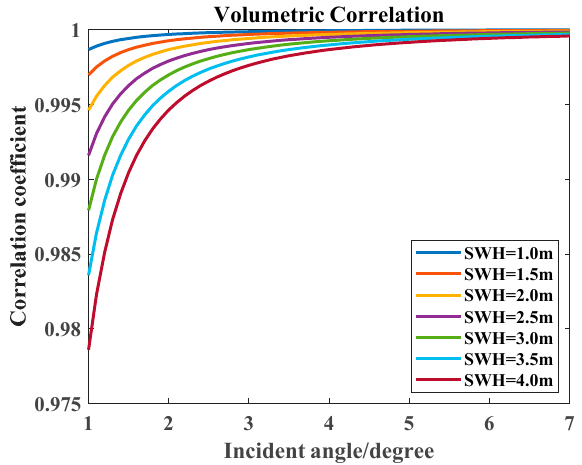
Figure 5. Volumetric decorrelation varies with incident angle and SWH.